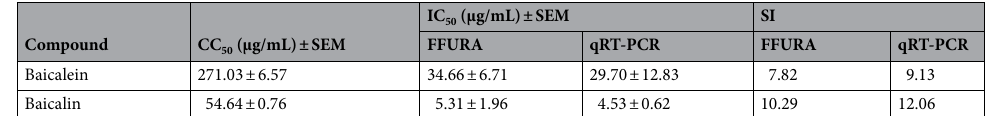
Table 3. The half-maximum inhibitory concentration (IC 50 ) and selective index (SI) of flavonoids against DENV-3 progeny. IC 50 refers to the 50% inhibitory concentration required to inhibit the viral progeny and was obtained from the post-infection assay. SI is a selective index (CC 50 /IC 50 ). FFURA measures the infectious virus particles, while qRT-PCR measures the viral RNA copy number. Data were acquired from three independent experiments and presented as mean ± standard error mean (SEM).